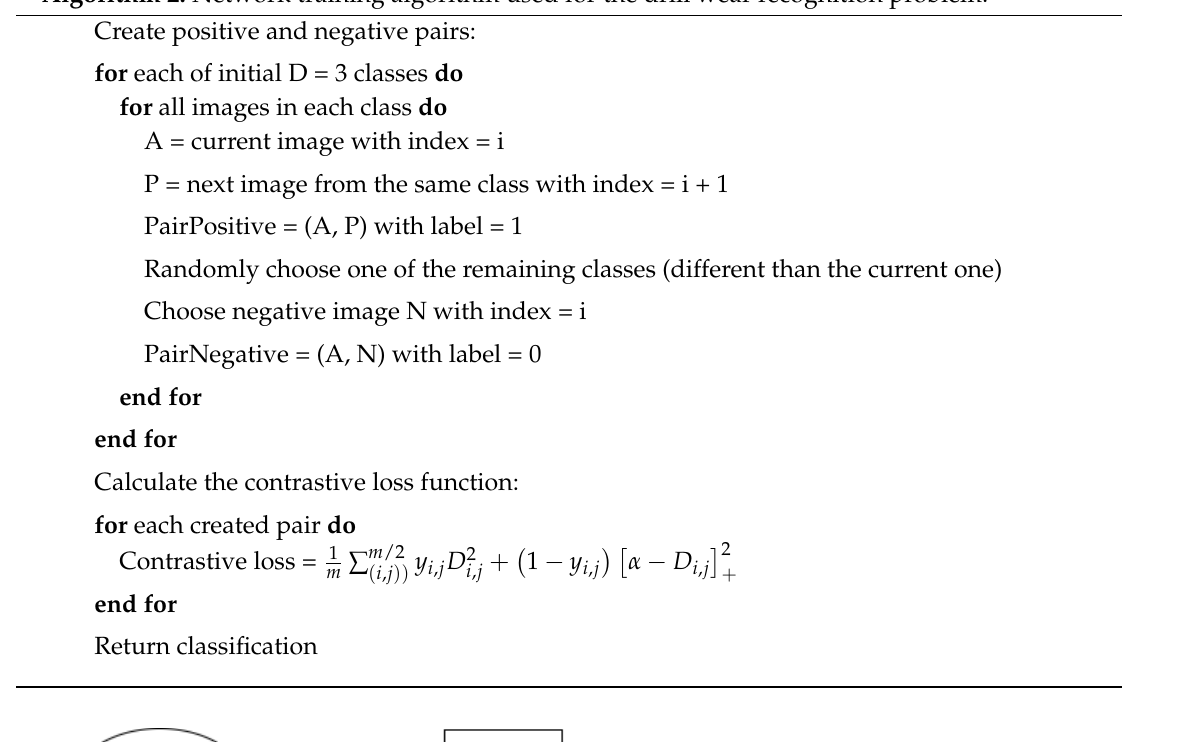
Algorithm 2: Network training algorithm used for the drill wear recognition problem.